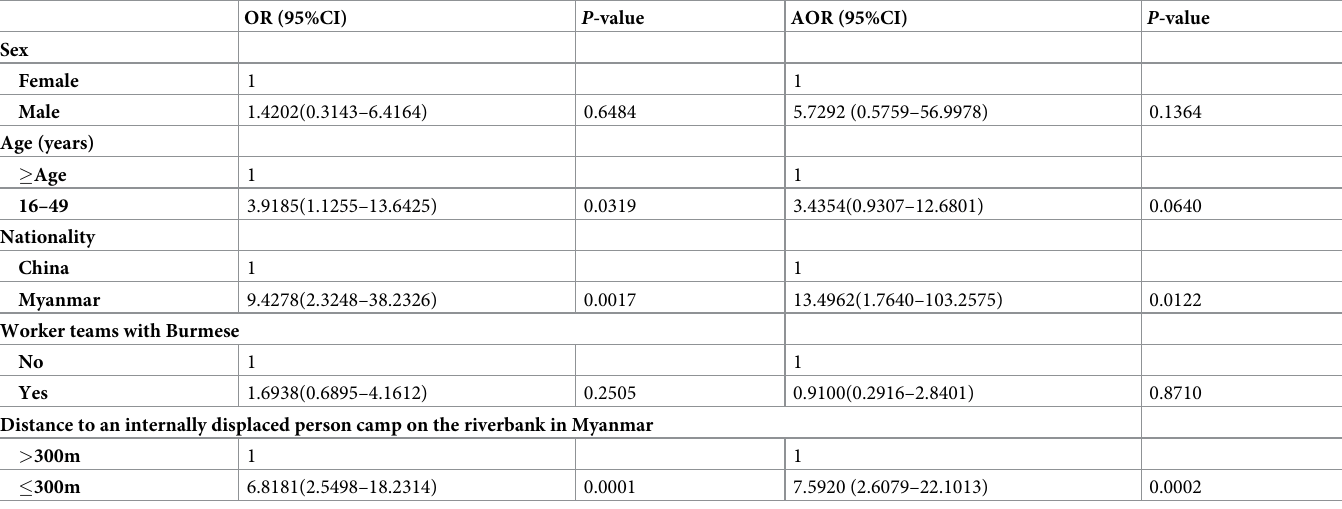
Table 3. Results of multivariate logistic regression analysis for risk factors associated with malaria infection during the border-malaria outbreak (N = 239). OR (95%CI) P